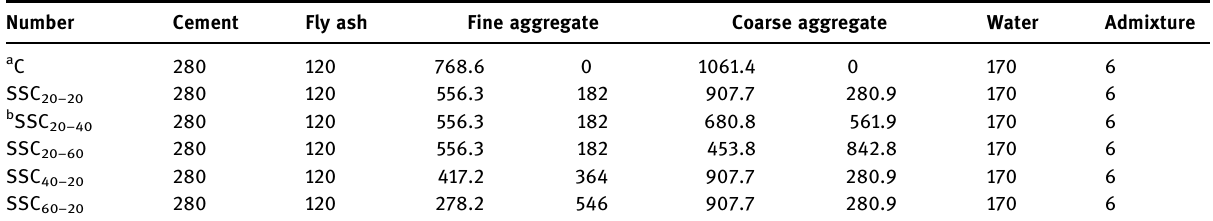
Table 6: Concrete mix ratio ( kg/m 3 )